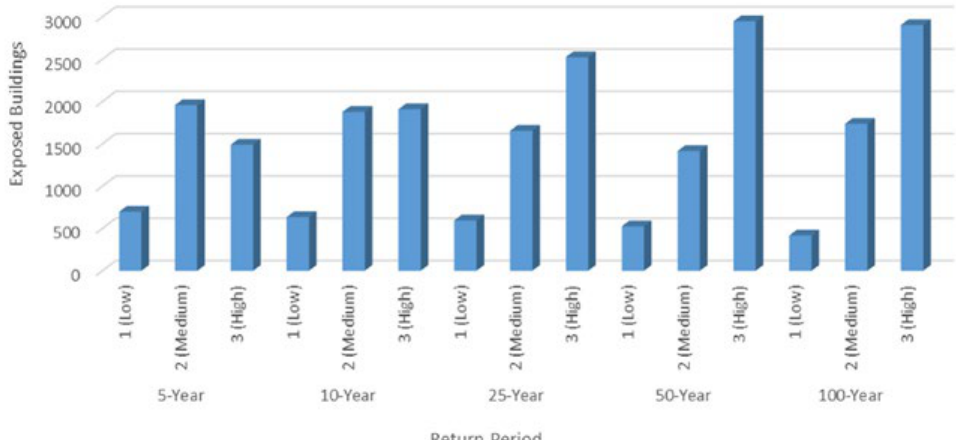
Fig. 10: Number of exposed building per return periods